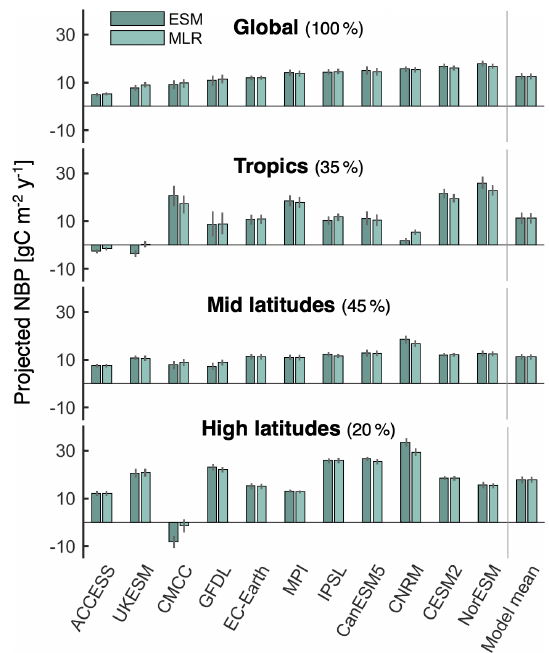
Figure 6. Comparison of average projected NBP from Earth sys- tem models (ESMs) with the multiple linear regression (MLR) esti- mate. Colored bars indicate the mean from the 200 bootstrap sam- ples, while uncertainty bars span from the 5th to the 95th per- centile. The spatial average is shown for global land, the tropics (22.5 ◦ S–22.5 ◦ N), mid latitudes (22.5–47.5 ◦ N over North Amer- ica, 22.5–55 ◦ N over Europe and Asia, and > 22.5 ◦ S), and high latitudes ( > 47.5 ◦ N over North America and > 55 ◦ N over Europe and Asia). The land percentage comprised in each region is noted next to the title: tropics represent 35.1% of the considered global land area, mid latitudes 44.8%, and high latitudes